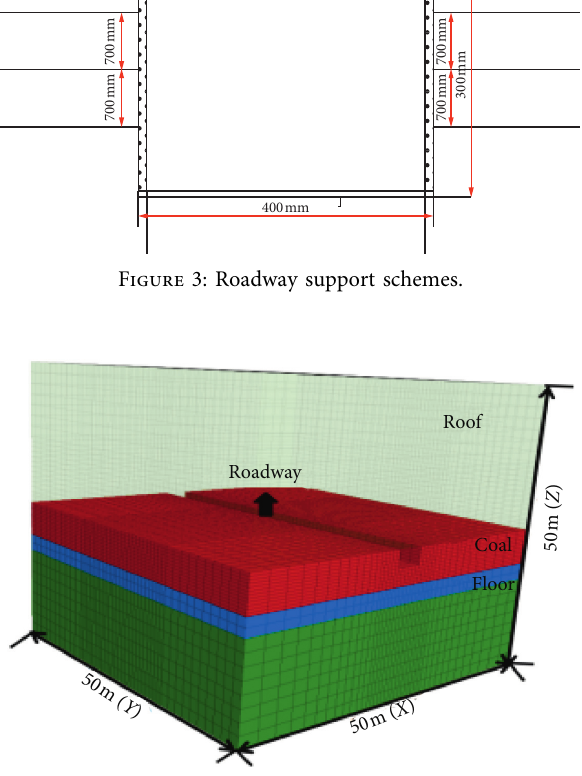
Figure 4: Numerical